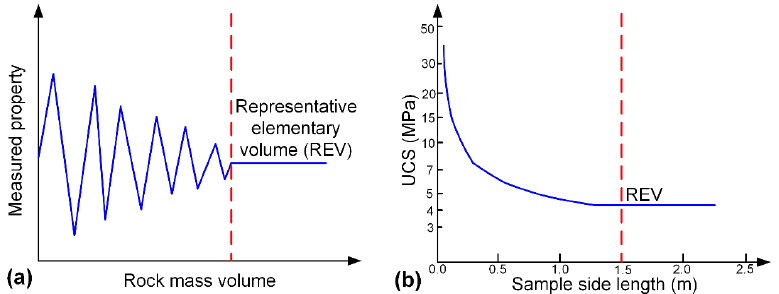
Figure 6. ( a ) Concept of the REV (after Bear, [49]). ( b ) The effect of sample size on the strength of coal (after Bieniawski, [50]).